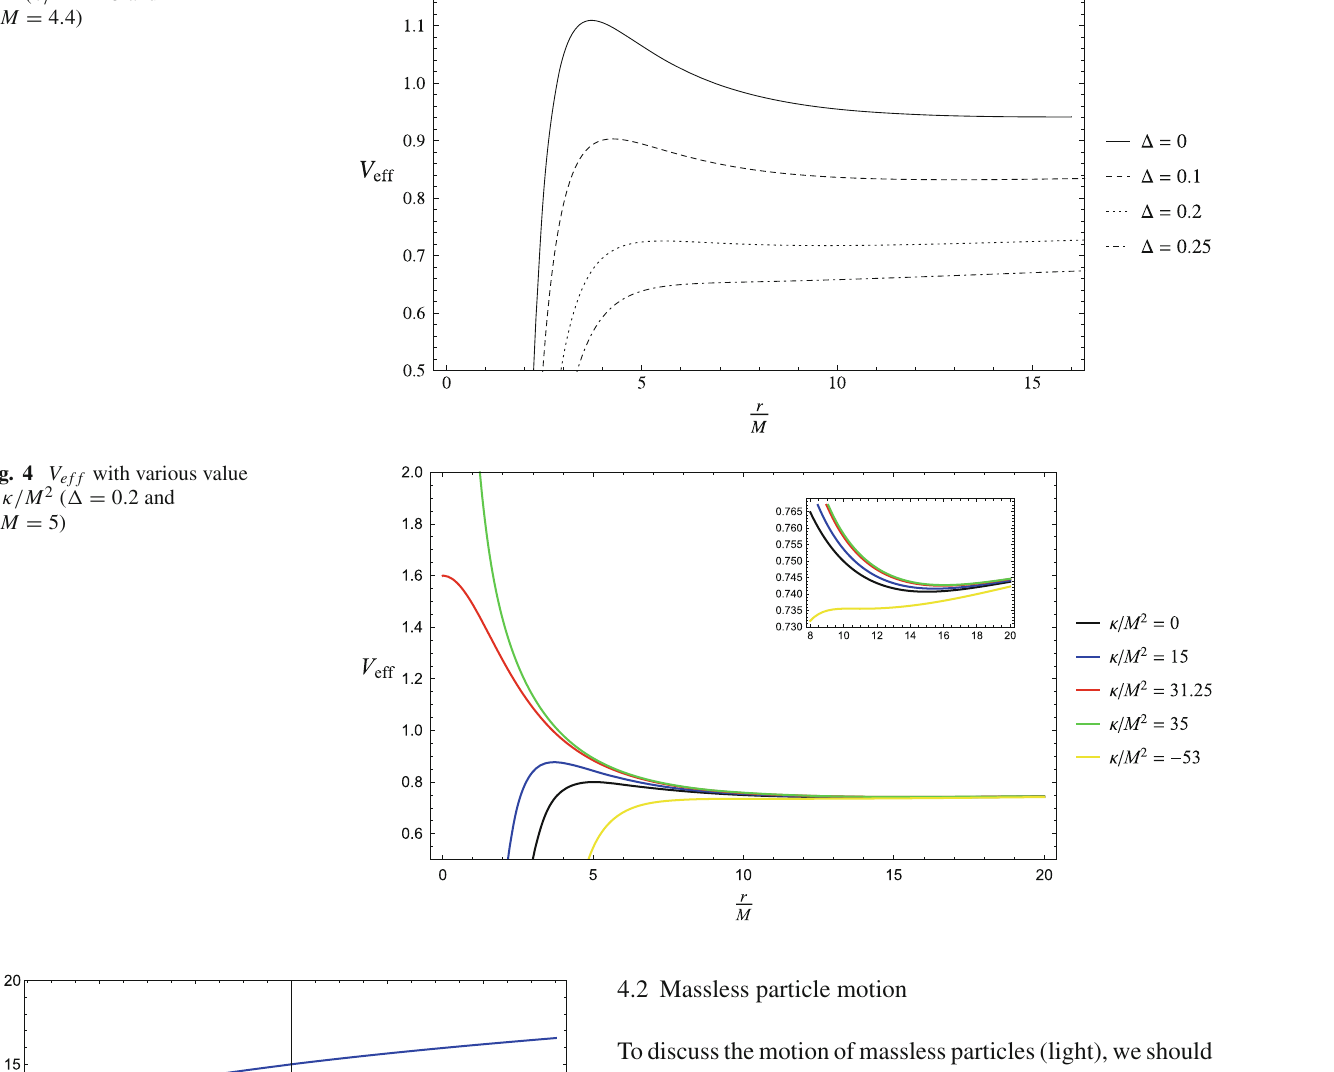
Fig. 3 V ef f with various value of (cid:19) ( κ/ M 2 = 5 and (cid:21)/ M = 4 . 4)